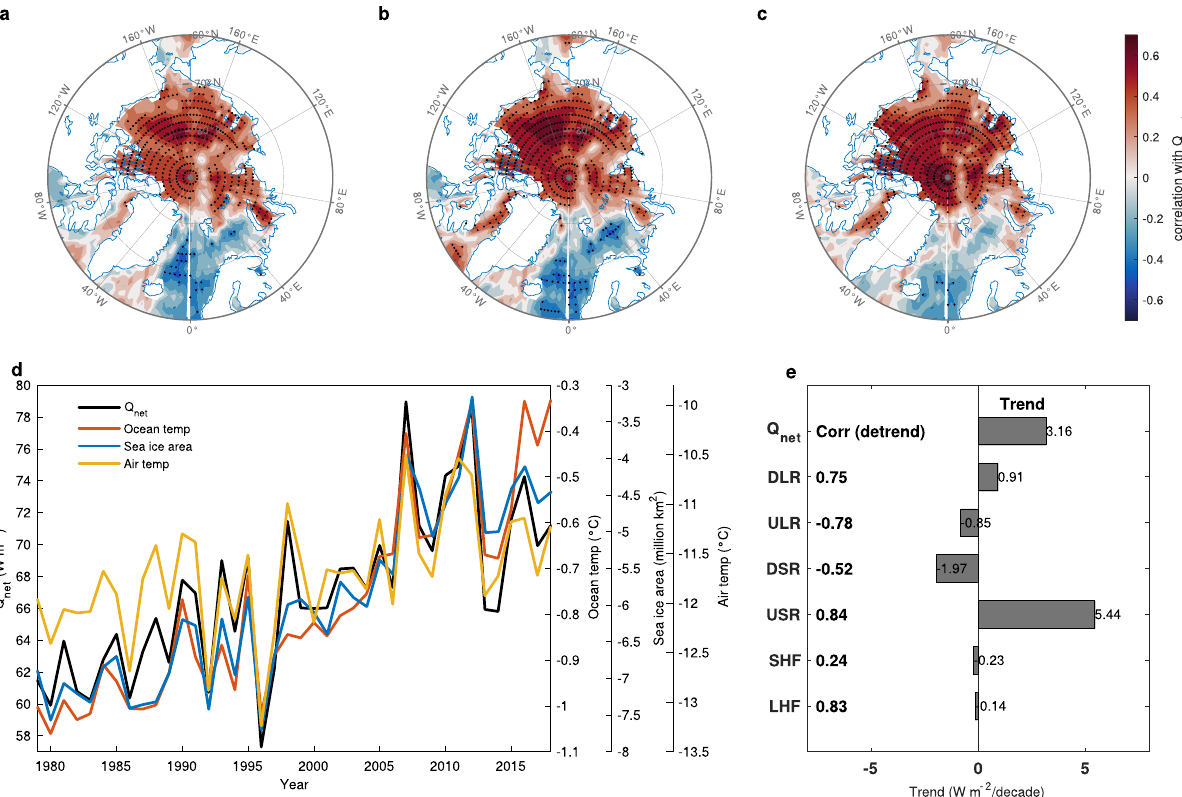
Fig. 2 Important role of radiation fl uxes in linking atmosphere, sea ice, and ocean. Correlations of 1979 – 2018 ERA5 reanalysis JJA net downward heat fl ux (Q net ) fi eld with three time series, i.e., a SON domain-average upper (0 – 50m average) ocean temperature, b September sea ice area (SIA; average over 70° – 90°N, 0 – 360°, the sign of SIA is reversed for simplicity of comparison with plots a , c ), and c JJA domain-average tropospheric (surface to 300hPa average) air temperature. d Domain-average time series for JJA Q net (Wm − 2 ), SON upper ocean temperature (°C), September SIA (million km 2 , the sign of SIA is reversed), and JJA tropospheric air temperature (°C) from 1979 to 2018. e Linear trends (Wm − 2 per decade) of JJA domain-averages of Q net , downwelling longwave radiation (DLR), upwelling longwave radiation (ULR), downwelling shortwave radiation (DSR), upwelling shortwave radiation (USR), sensible heat fl ux (SHF), and latent heat fl ux (LHF) from the ERA5 reanalysis (1979 – 2018). All radiative fl ux variables are positive downward. Correlations of JJA domain-average Q net with JJA domain- averages of DLR, ULR, DSR, USR, SHF, and LHF in the ERA5 reanalysis for the period 1979 – 2018 are shown in bold next to the y -axis. All linear trends are removed in calculating the correlations in a – c and e . Black stippling in all plots indicates statistically signi fi cant correlations at the 95% con fi dence